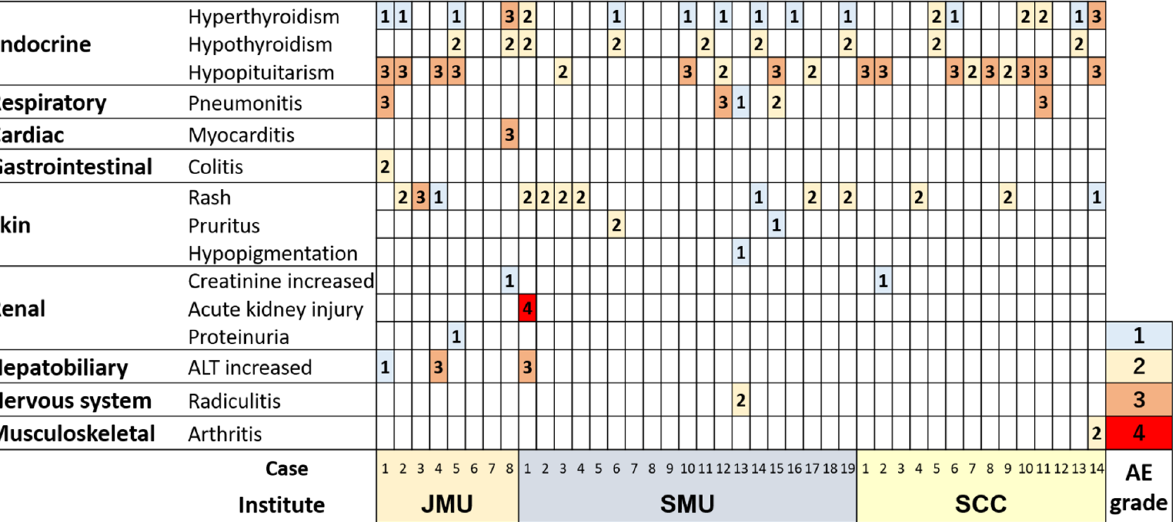
Figure 3. The grades of individual irAEs in each patient. JMU: Jichi Medical University Saitama Medical Center; SMC: Saitama Medical Center Saitama Medical University, SCC: Saitama Cancer Center; AE: adverse events.